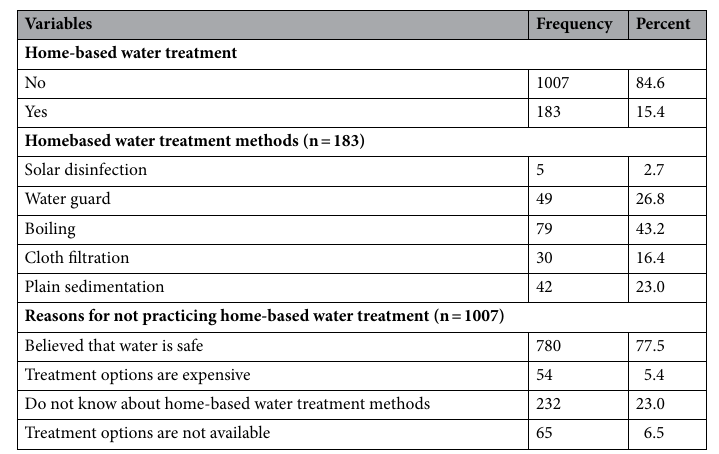
Table 4. Household water treatment practices among households (n = 1190) in a rural setting of northwest Ethiopia, May 2016.